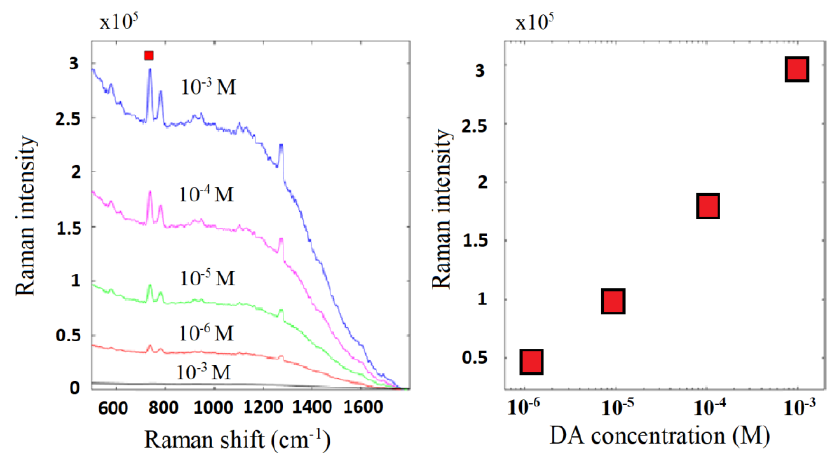
Figure 8. ( a ) SERS spectra of Rh6G (10 − 5 , 10 − 4 and 10 − 3 M) onto G-NH 2 / Au platform; G-NH 2 platform (10 − 4 M, black line) and AuNPs film (10 − 4 M Rh6G reported in the inset), by using the 638 nm laser excitation. ( b ) Optical absorption spectra of freshly prepared Au NPs (red line) and G-NH 2 / Au (blue line, 0.4 mg / mL).